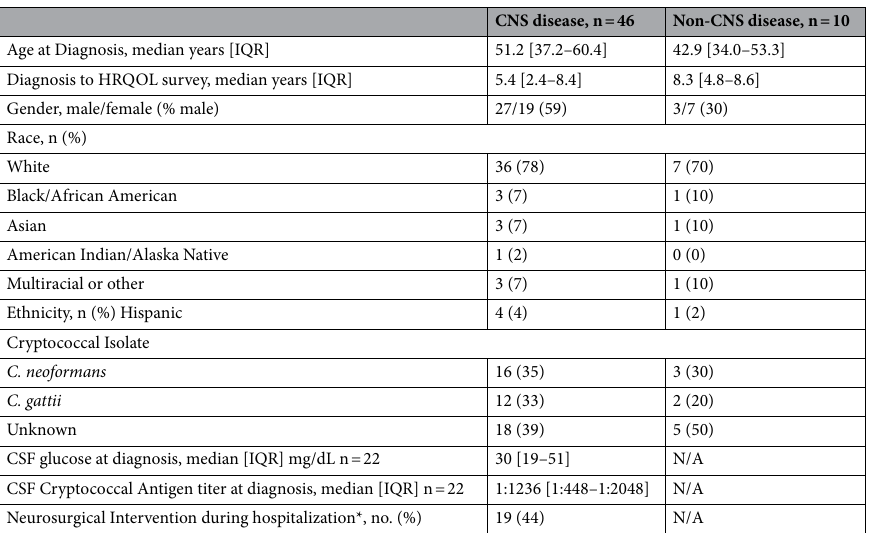
Table 1. Patient demographic and clinical characteristics. CSF: cerebrospinal fluid; *18/19 with neurosurgical intervention (95%) had a ventriculoperitoneal shunt placement, 1 (5%) had a lumbar drain